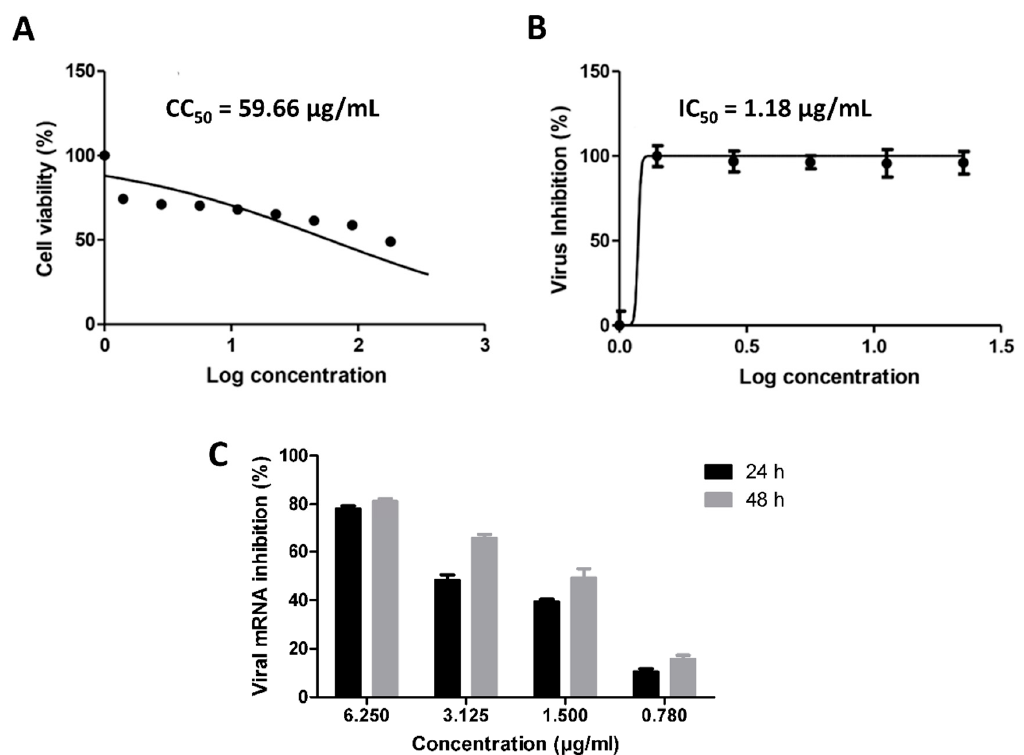
Figure 5. Cytotoxicity and in vitro anti-SARS-CoV-2 activity of cnicin ( A and B , respectively), in addition to viral mRNA% inhibition ( C ). Nonlinear regression analysis of the GraphPad Prism software (version 5.01) was used to calculate the IC 50 values.